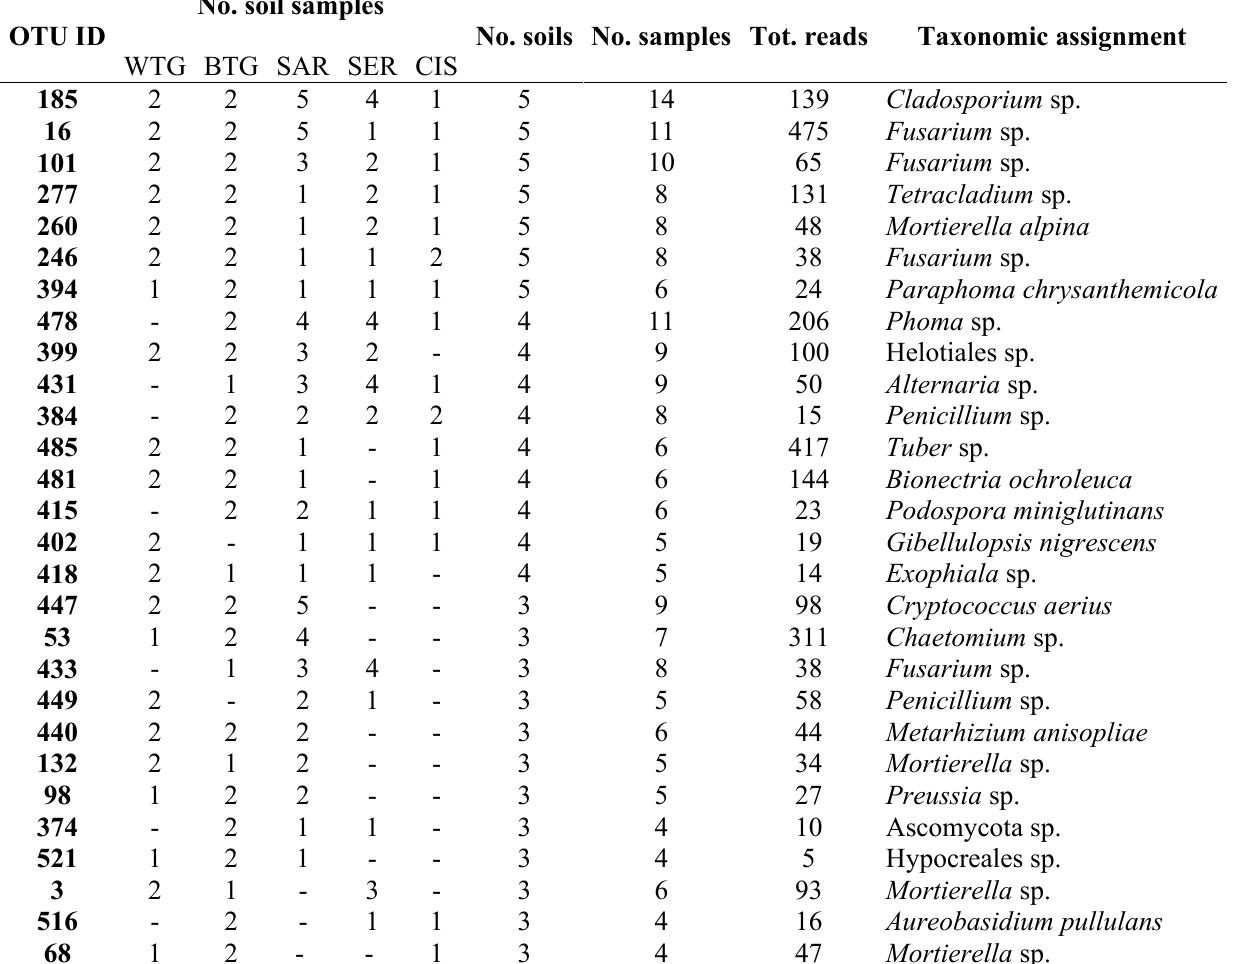
Table 3. ITS2 OTUs occurring in at least three soil sample groups (WTG, BTG, SAR, SER and CIS). Occurrence in the examined soil samples and sample groups, total number of clustered reads and taxonomic assignment are reported for each OTU. OTUs are listed according to decreasing frequency (no. soils and samples they were retrieved from).